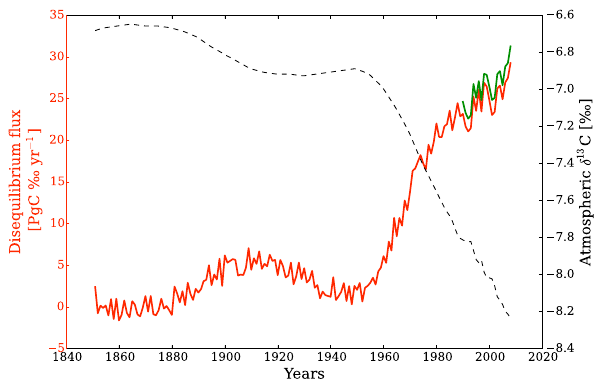
Figure 6. Time series (1851–2008) of the global annual dise- quilibrium flux for two different experiments: ISOVAR (red) and ISOVAR-NF (green). The ISOVAR-NF simulation is only shown for the period 1990–2008. Since disequilibrium is strongly linked with atmospheric isotopic composition, δ a (dashed) is added on the secondary y